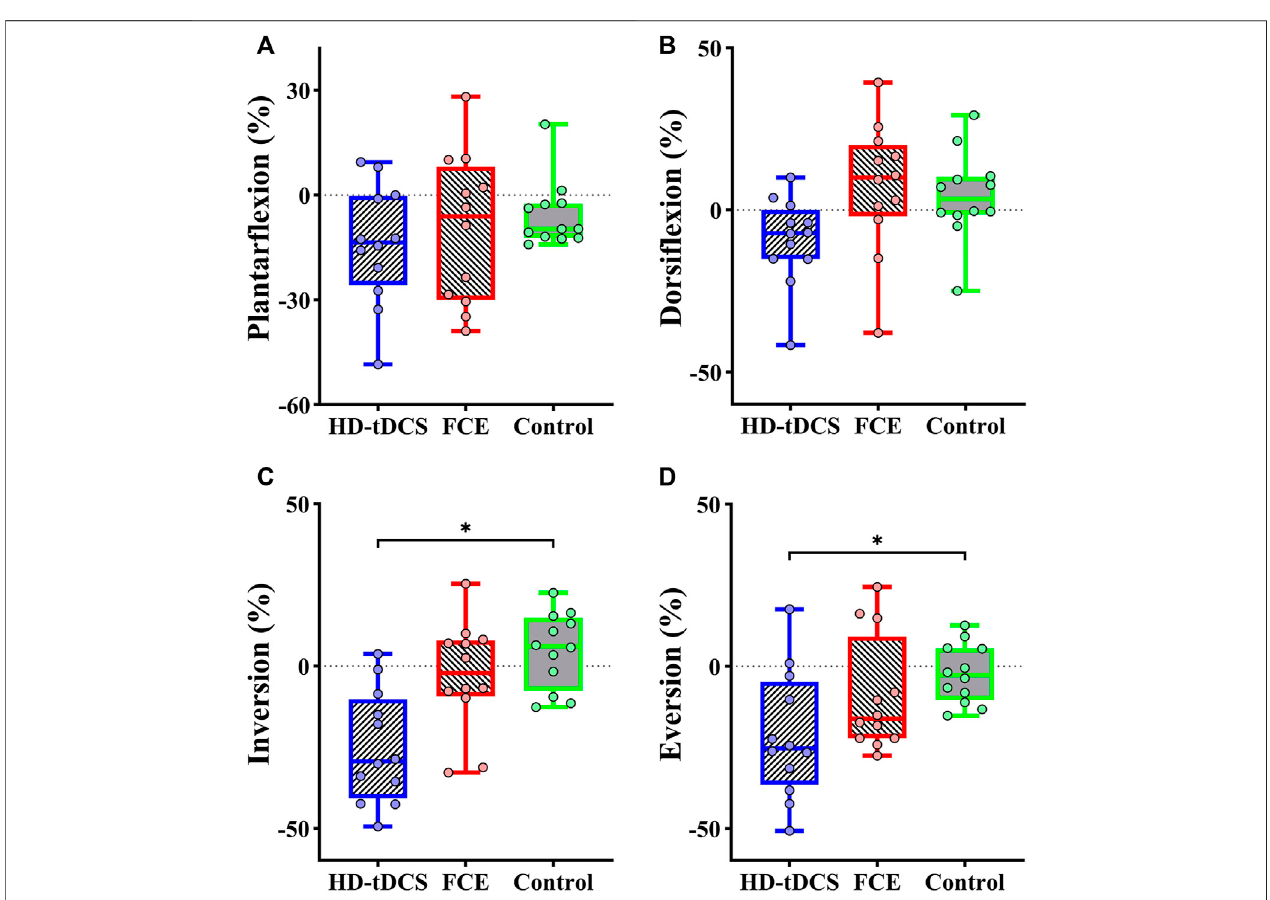
FIGURE3| Differences inpercentchangesinthepassivekinesthesia thresholds of (A) plantar fl exion, (B) dorsi fl exion, (C) inversion,and (D) eversionfrom baseline to post-intervention among groups. HD-tDCS: high-de fi nition transcranial direct current stimulation; FCE: foot core exercise; p p < 0.05.